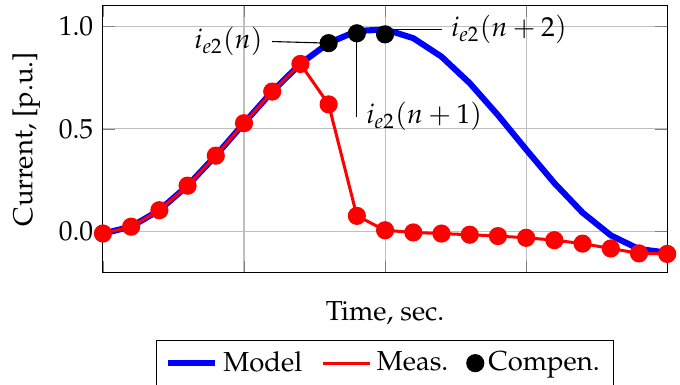
Figure 1. Artificial expansion of US.